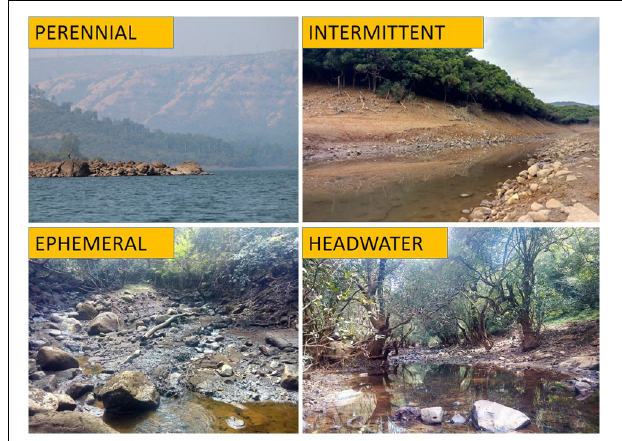
FIGURE 2 | Different habitat types selected for the